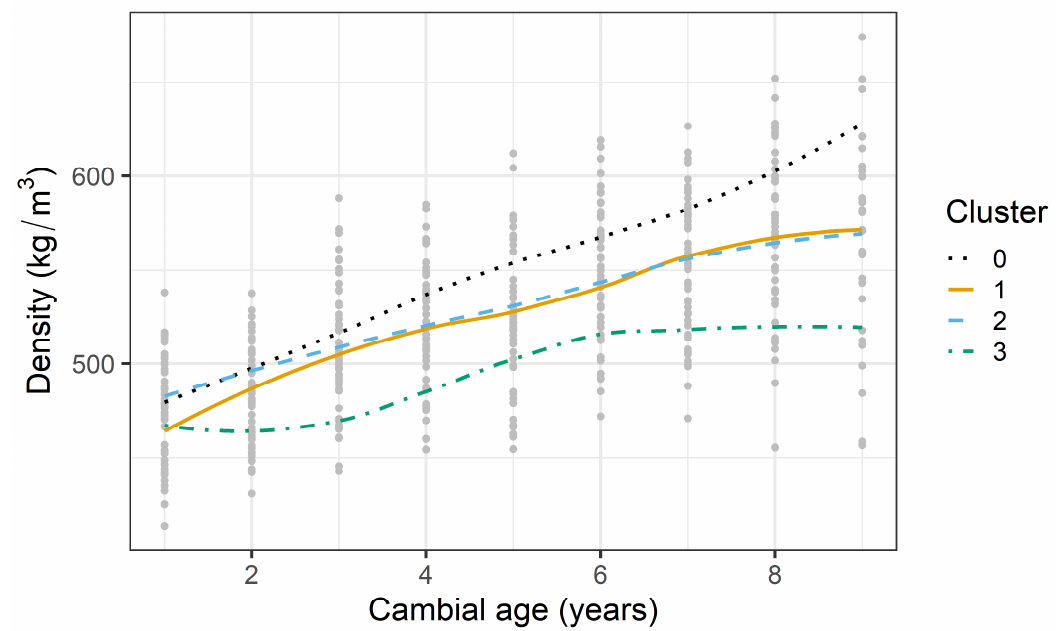
Figure 4. Density radial variation for trees representing the average wood property values of each cluster. Figure4.